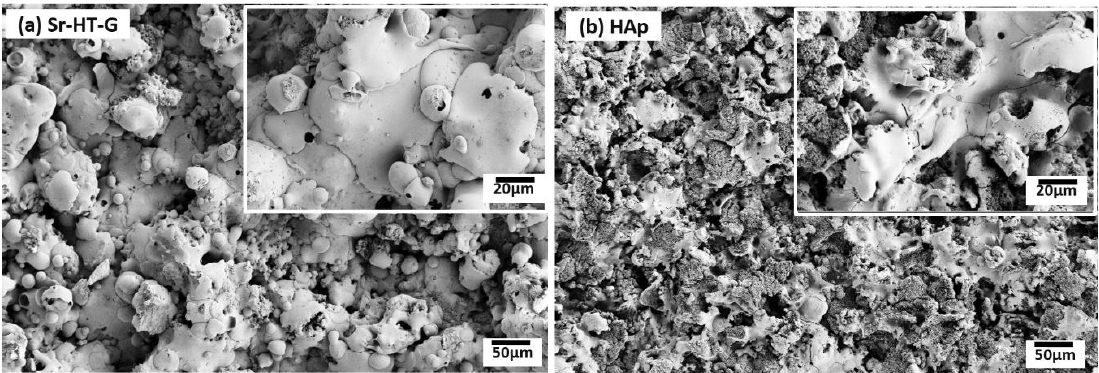
Figure 4. SEM of coating surfaces of Sr–HT–G ( a ) and HAp ( b ).